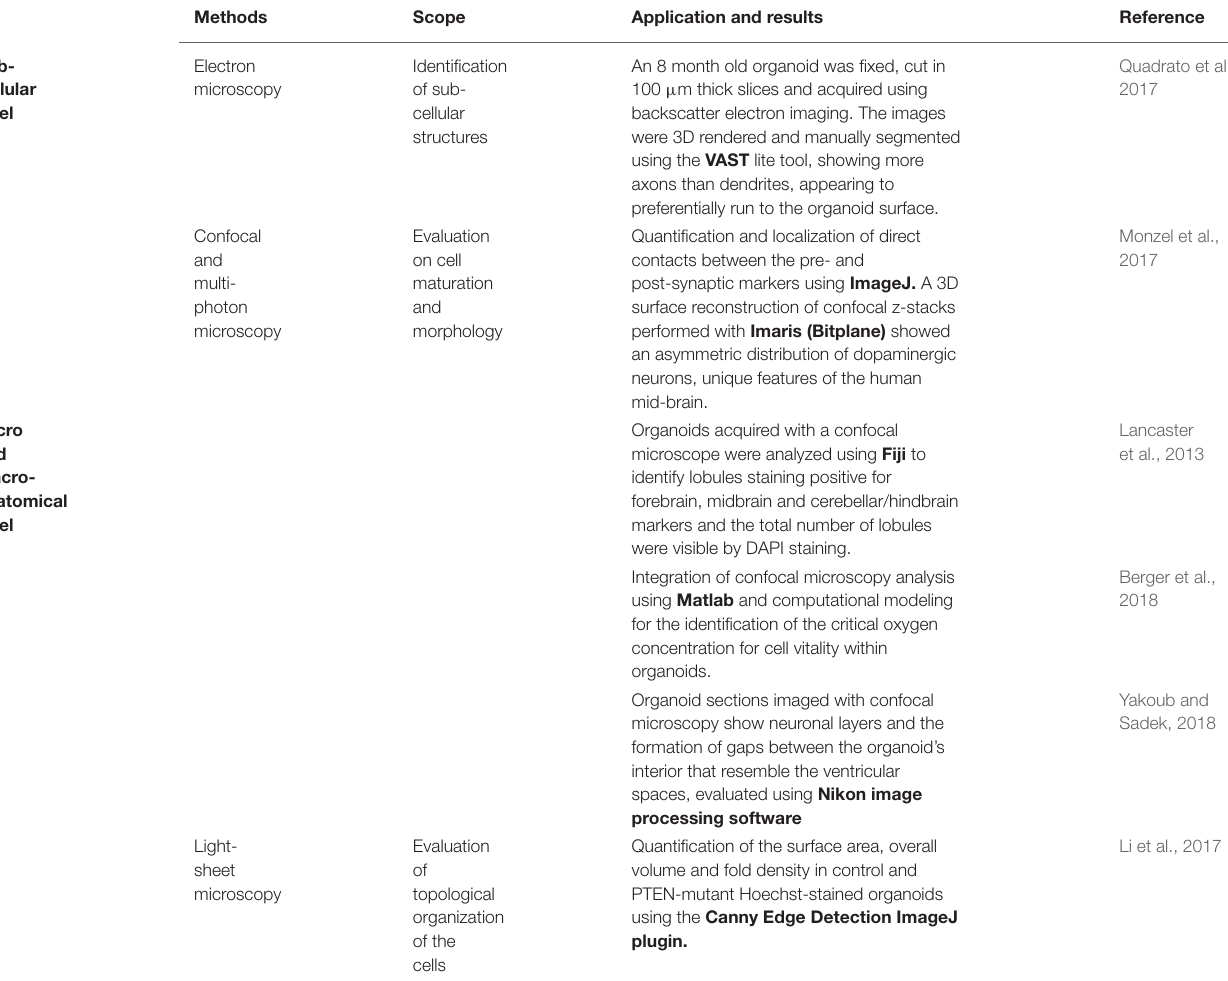
TABLE 1 | Structural characterization of brain organoids using quantitative image processing: The